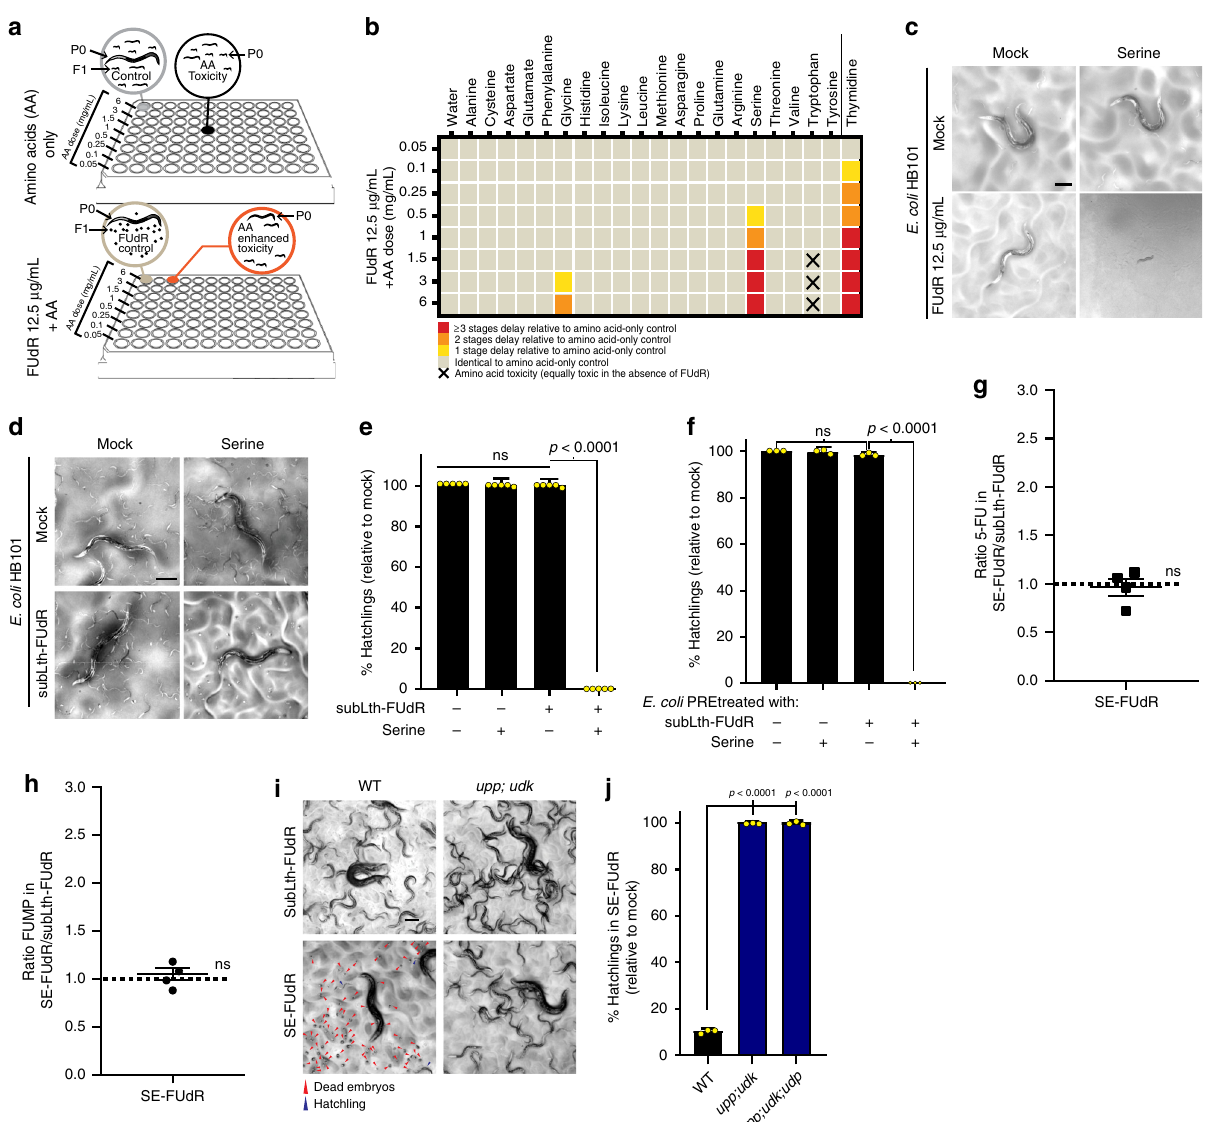
Fig. 2 Dietary serine enhances FUdR toxicity but not FUdR-to-FUMP conversion. Throughout this fi gure: % hatchlings and LC – MS data were analyzed as described in Fig. 1. Statistical signi fi cance was assessed via two-tailed unpaired nonparametric t -test for % hatchlings quanti fi cation. LC – MS data were analyzed using one-tailed ratio t -test after ROUT outlier treatment. Data are presented as mean values ± SEM, scale bars = 200 µ m, n = # independent biological replicates. Source data are provided as a Source Data fi le. a Screen setup to search for dietary amino acids (AAs) that enhance FUdR toxicity (cause developmental delay). Worms cultured on E. coli HB101 were treated with 12.5 µ g/mL FUdR from the L1 stage ± serial dilutions of AAs (0.05 – 6 mg/mL). AA-only wells were included to detect AA toxicity. Wells were scored after 60 h at 20 °C, when FUdR-only wells show 100% embryonic lethality but no developmental delay. b Heat map representing degree of developmental delay caused by supplemented AAs. Color and symbol key depicted below. Thymidine is a positive control. c Representative images of targeted validation of developmental delay induced by co-administration of 12.5 µ g/mL FUdR with 1.5 mg/mL of serine. Images taken after 60 h of incubation at 20 °C. n > 3. d Representative images of progeny viability of C. elegans cultured on HB101 and treated from L1 with mock, subLth-FUdR (1 μ g/mL FUdR, which is sublethal because using HB101), 1.5 mg/mL serine, or subLth- FUdR plus serine. n > 10. e Quanti fi cation of % hatchlings relative to mock of treatments represented in d . n = 5. f Quanti fi cation of % hatchlings in worms exposed to lawns of E. coli pretreated “ in tube ” with ±subLth-FUdR ±serine. In this setup, worms are not directly exposed to FUdR or serine (Supplementary Fig. 4). n = 3. g LC – MS measurement of intracellular 5-FU relative to internal standard (IS) [1,3- 15 N2]Uracil in E. coli treated with subLth-FUdR plus serine compared to subLth-FUdR. n = 4. h LC – MS measurement of intracellular FUMP relative to internal standard (IS) [ 13 C9, 15 N2]UMP in E. coli treated with subLth-FUdR plus serine compared to subLth-FUdR. n = 4. i Representative images of progeny viability of C. elegans cultured on WT (BW25113) or upp;udk KO E. coli lawns treated from L1 with subLth-FUdR (0.25 μ g/mL) ± serine. j Quanti fi cation of % hatchlings relative to mock of treatments represented in i and the triple E. coli KO upp;udp;udk . n =